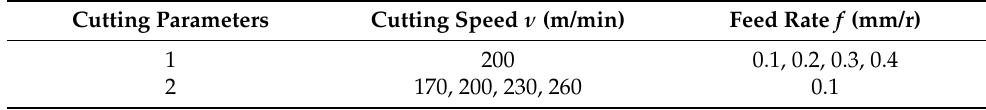
Table 3. Selection of simulation cutting parameters.